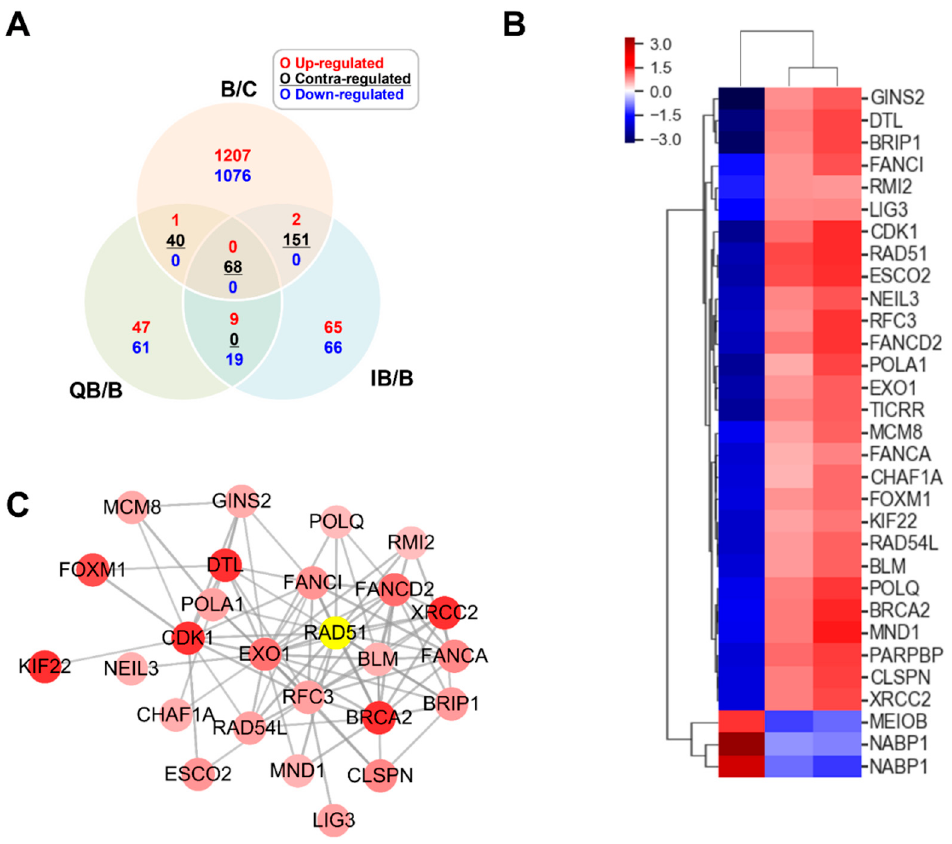
Figure 2. Quercetin or isorhamnetin suppressed the B[a]P-induced downregulation of RAD51. ( A ) Among the differentially expressed genes (DEGs, ≥ 2.0 folds, presented on a Venn diagram), between B[a]P − treated cells and cells co − treated with B[a]P and quercetin or isorhamnetin, 68 genes are contra-regulated by quercetin and isorhamnetin each. ( B ) Among the 68 DEGs, 31 genes are related to DNA repair. The heatmap of hierarchical clustering of the 31 genes was constructed using their z-scores. Red and blue indicate upregulation and downregulation, respectively. ( C ) The 31 DEGs were subjected to protein–protein interaction (PPI) analysis according to the STRING database. The module enrichment was based on the PPI network with a cutoff criterion of MCODE score > 0.8. Each node and line represent a gene and co-expression relationship, respectively. The bold lines indicate that the connected nodes have a strong co-expression relationship. GO; gene ontology, Q; quercetin, I; isorhamnetin, B; B[a]P.